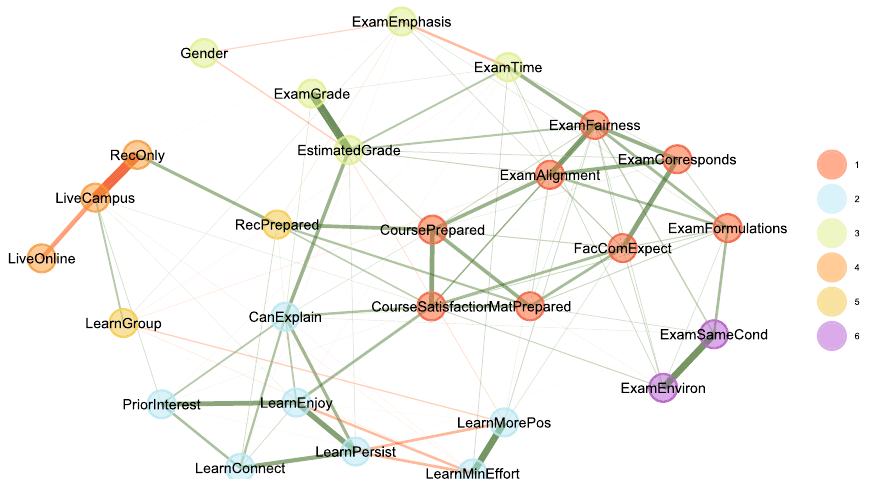
Fig. 7 Same as Fig. 6, but only for courses that included recordings (12,939 completely filled out surveys), and including the corresponding